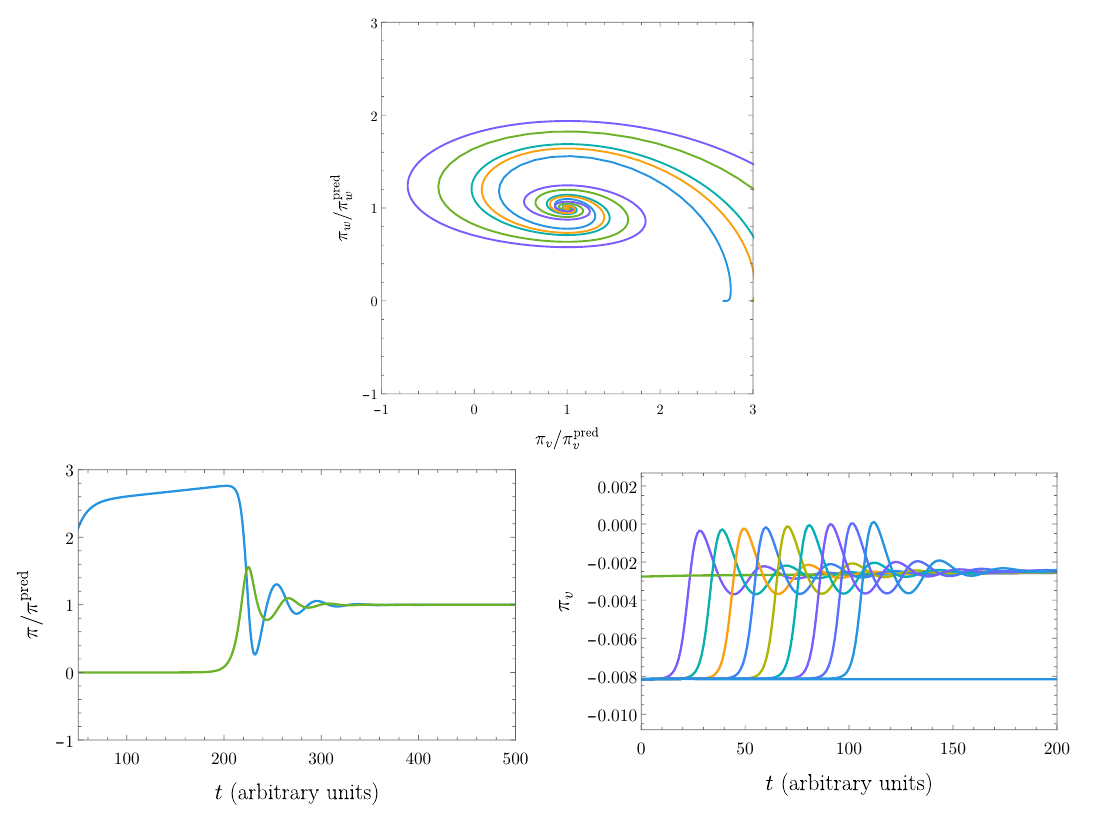
Figure 2 . Three graphs for the antisymmetric hyperin(cid:13)ation model of example 3. The top (cid:12)gure shows (cid:12)ve trajectories in (cid:12)eld space converging to the hyperin(cid:13)ation attractor. The left (cid:12)gure shows how the momenta (cid:25) v and (cid:25) w converge to the correct values in one example. The right (cid:12)gure shows how slow-roll with a small velocity in the w -direction quickly becomes unstable for (cid:25) w;i =(cid:25) v;i = 10 (cid:0) 2 ; : : : ; 10 (cid:0) 10